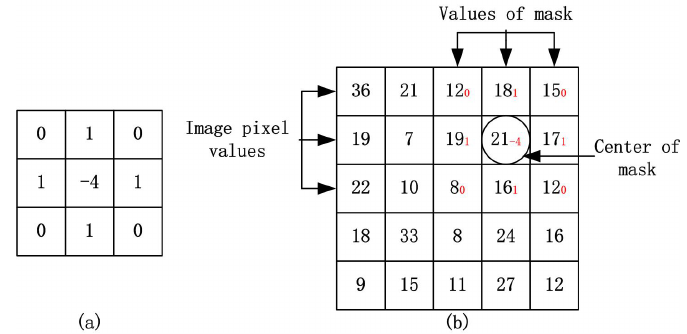
Figure 3. The process of the Laplacian filter sharpening: ( a ) the digital mask filter w , ( b ) the convolution